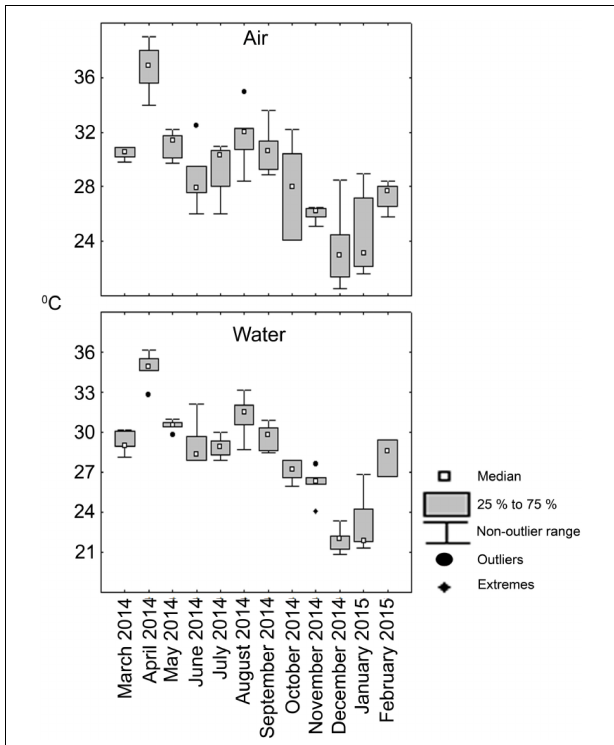
FIGURE 2 | Box and whiskers plot depicting the variation of temperature ( ◦ C) in the lagoon observed during the sampling period.